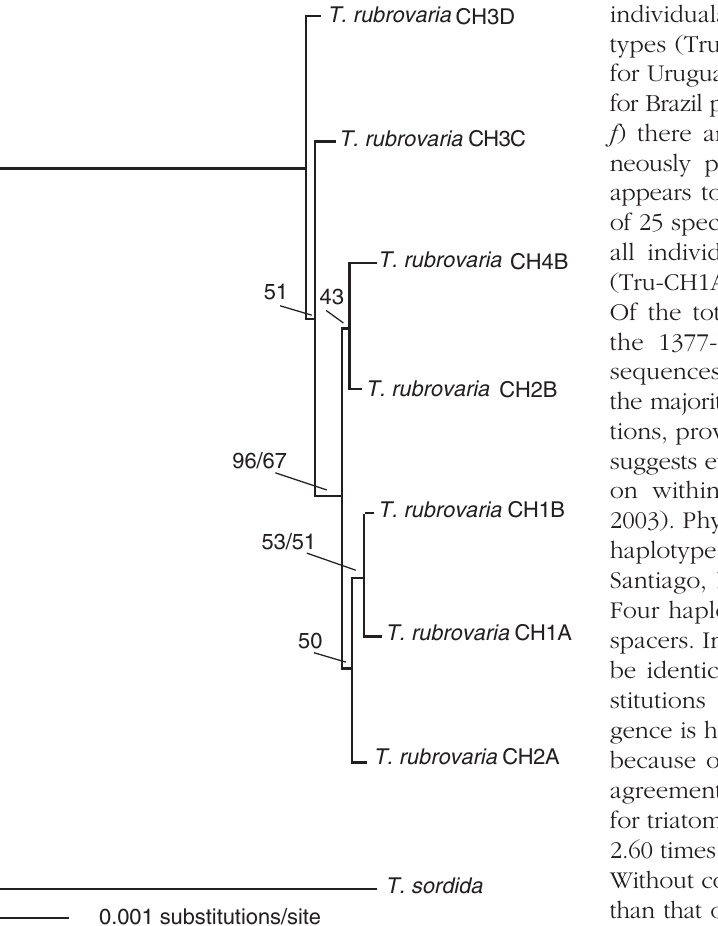
Fig. 3. – Phylogenetic tree of T. rubrovaria haplotypes, based on complete sequences of rDNA ITS-1, 5.8S and ITS-2, derived from the maximum likelihood (ML HKY85+I) model using Triatoma sor- dida as outgroup. Numbers represent the percentage of 1,000 puzz- ling/bootstrap replicates. Scale bar indicates the number of substi- tutions per sequence